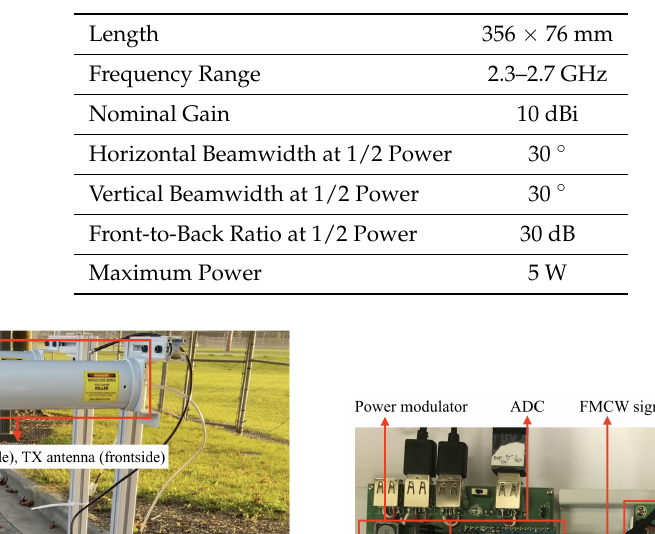
Table 2. Antenna specification.